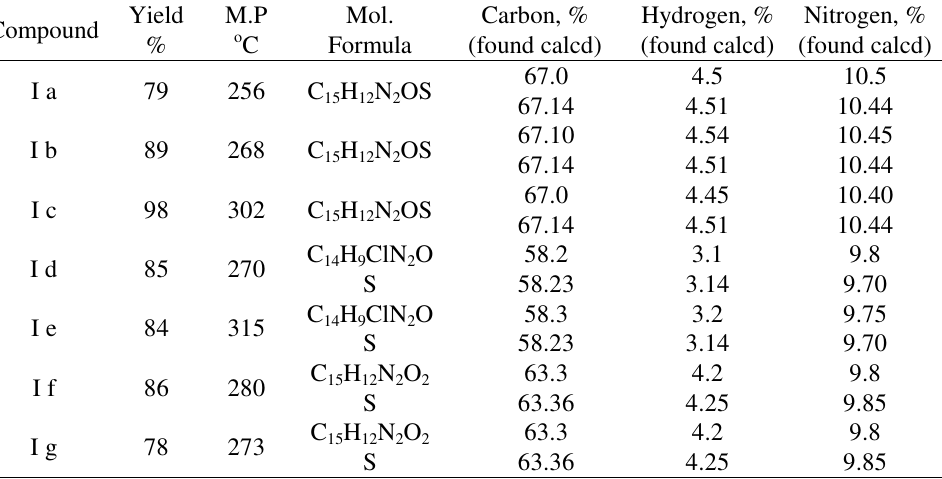
Table 1. General characteristics and elemental analysis data of the compounds I (a-g)